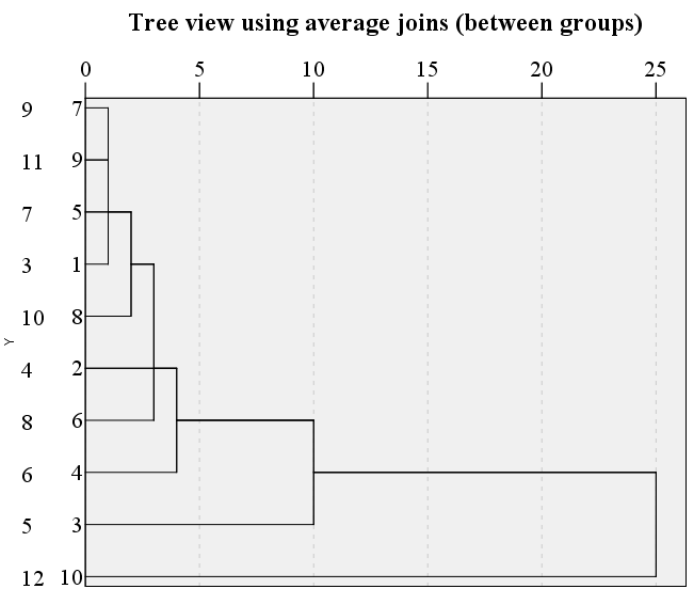
Figure 12. Cluster analysis of Permian sandstone fissure water system.